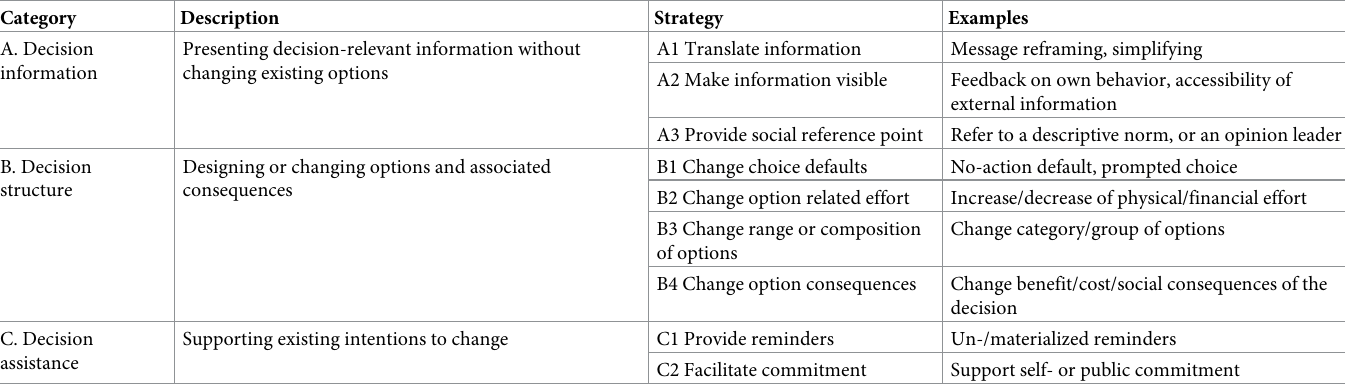
Table 2. Choice architecture categories and strategies by Mu¨nscher et al.,